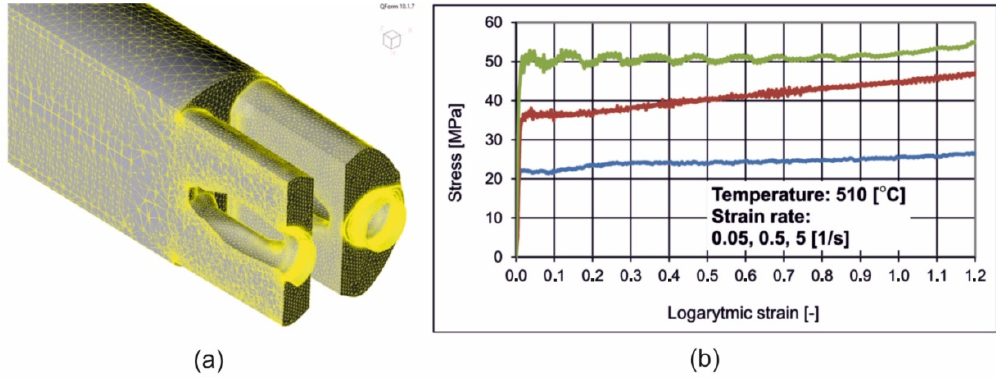
Figure 3. The geometrical model of extruded material with mesh elements ( a ) and determined material model for FEM calculations—dependence of flow stress vs. logarithmic strain for different strain rates for alloy 7021 ( b ): blue colour for 0.05 1/s, red colour for 0.5 1/s and green colour for 5 1/s.